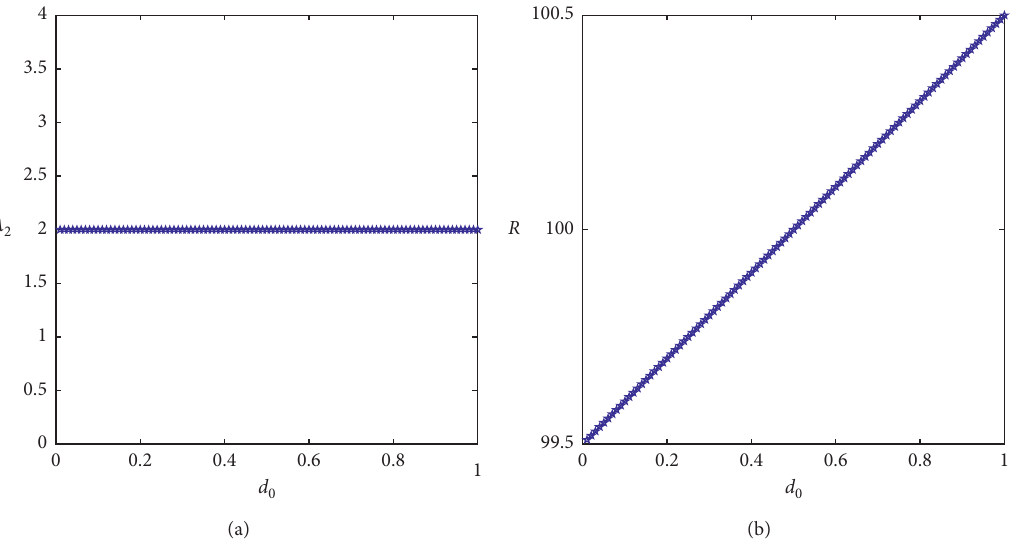
Figure 18: When N is even, the synchronizability of Network II varies with the interlayer coupling strength d changes with d ( d changes from 0.01 to 1); (b) R changes with d 0 0